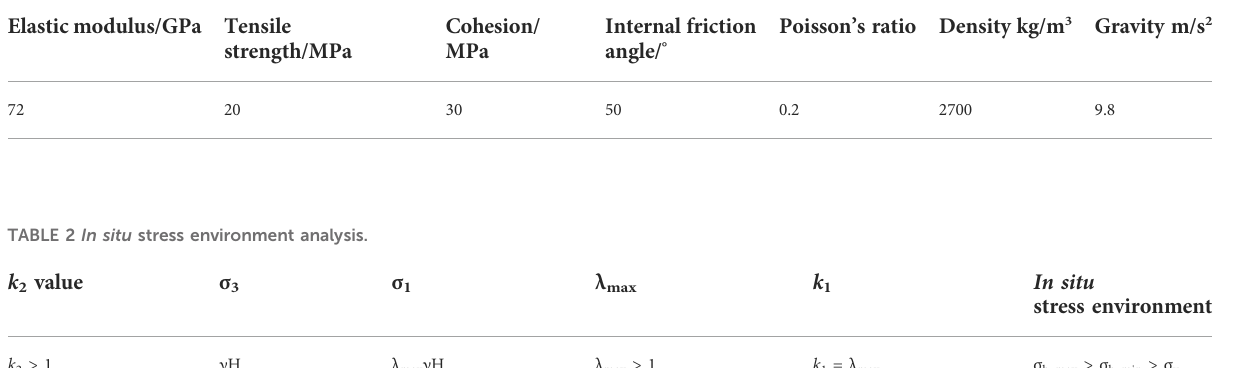
TABLE 1 Rock mechanics parameter list.